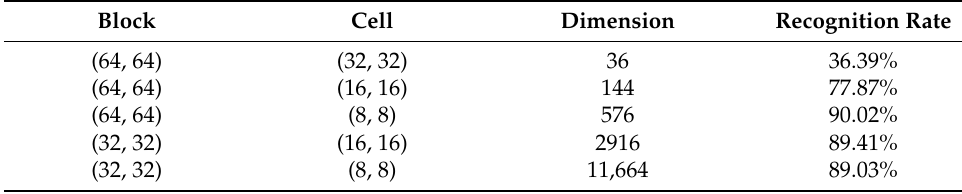
Table 1. Performance of HOG with different sizes.